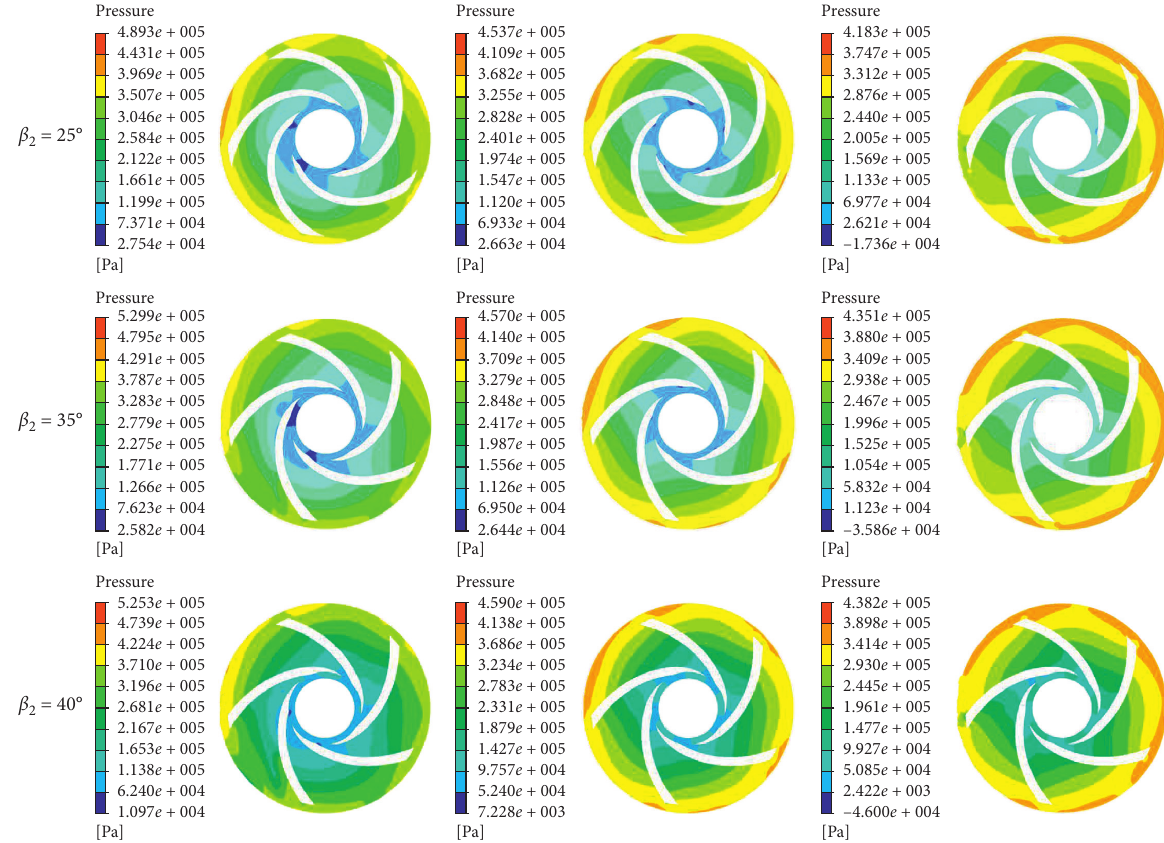
Figure 12: Pressure cloud chart with different outlet